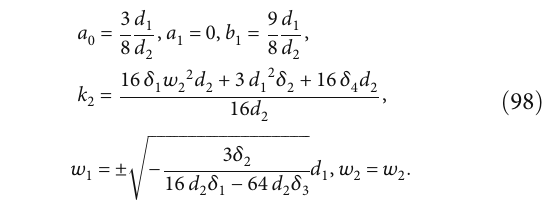
ð x , t Þj for NLFD of order α and for parameters δ 1